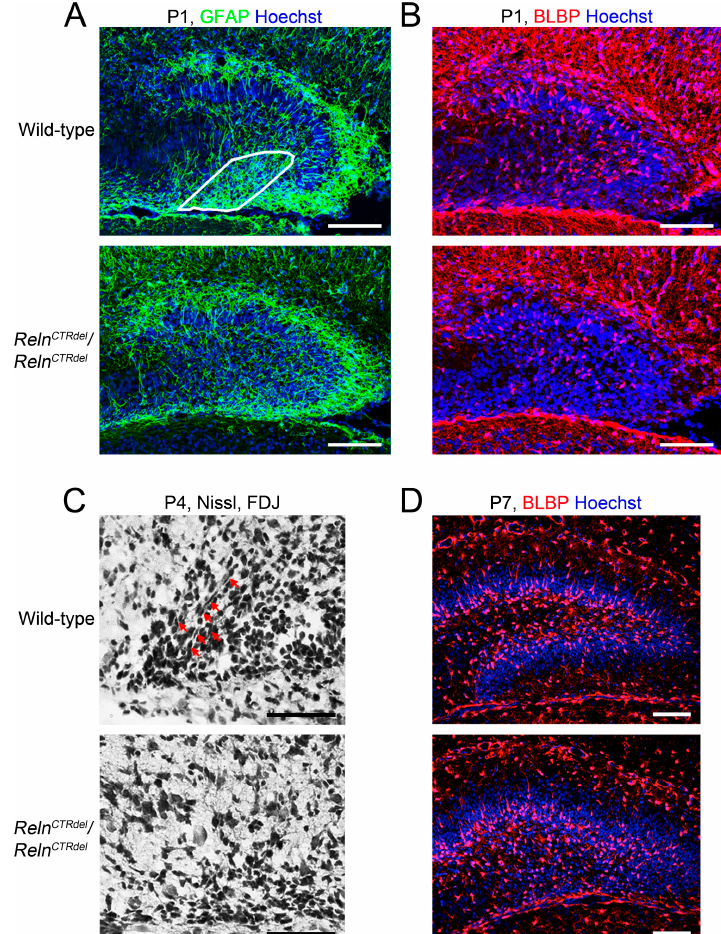
Figure A1. Cell death analysis. Activated caspase-3 (green) staining at P4 showed no abnormal increase in cell death in Reln CTRdel hippocampus. Nuclei were stained using Hoechst (blue).